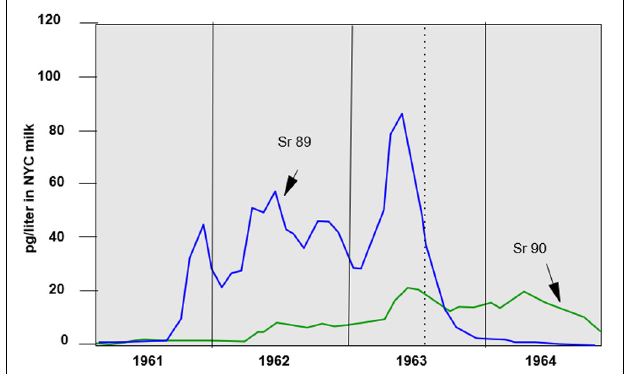
FIGURE 1 | Radioisotopes marketed in milk in New York City, 1960–1965.